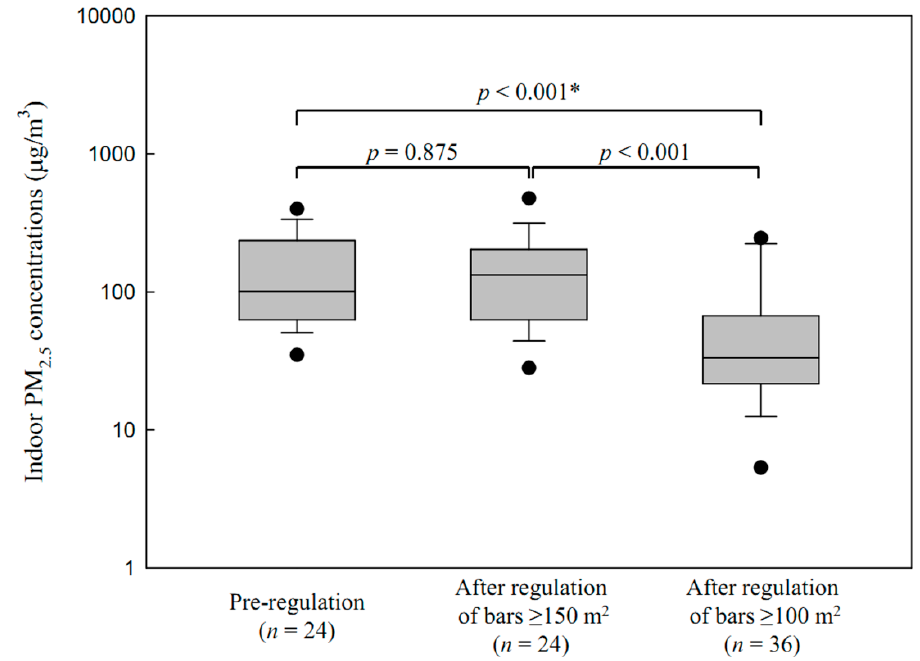
Figure 2. Distribution of indoor PM 2.5 concentrations in Seoul bars, pre-regulation, 100–149 m 2 , and after the regulation of bars ≥ 150 m 2 , bars ≥ 100 m 2 . * Student’s t -test.